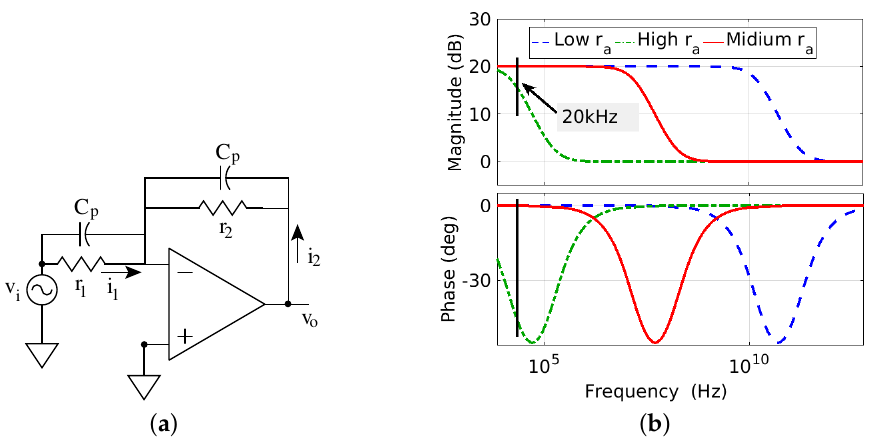
Figure 10. ( a ) Op-amp circuit for signal amplification gain “ a ”. ( b ) Bode plot of v o ( s ) / v i ( s ) utilizing low, high and medium values of resistance r a